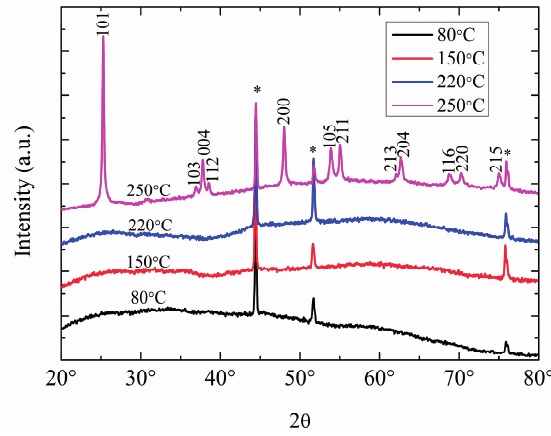
Figure 4. XRD patterns of pure TiO nanoparticles heat-treated at 80 °C, 150 °C, 220 °C, 2 and 250 °C were obtained by using CuK α radiation at λ = 1.5406 Å. (*) shows substrate Incubo